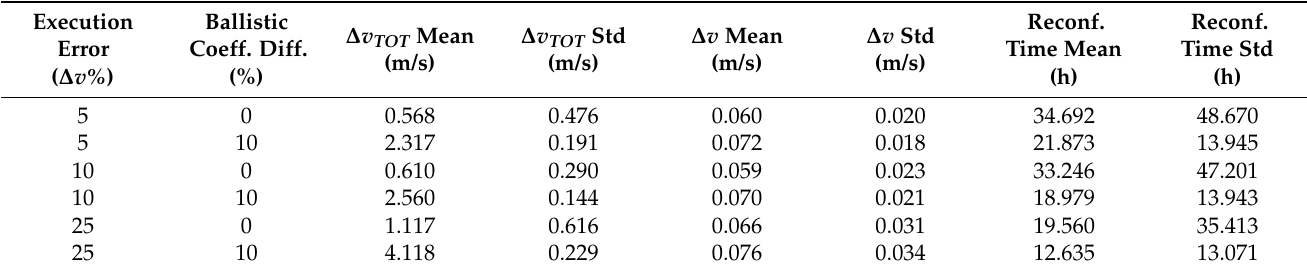
Table 7. Statistics related to the sensitivity analyses for maintenance of Sun-synchronous formations in the presence navigation errors ( σ p = 1 cm, σ v = 2.5 mm/s), maneuvering execution error, and ballistic coefficient